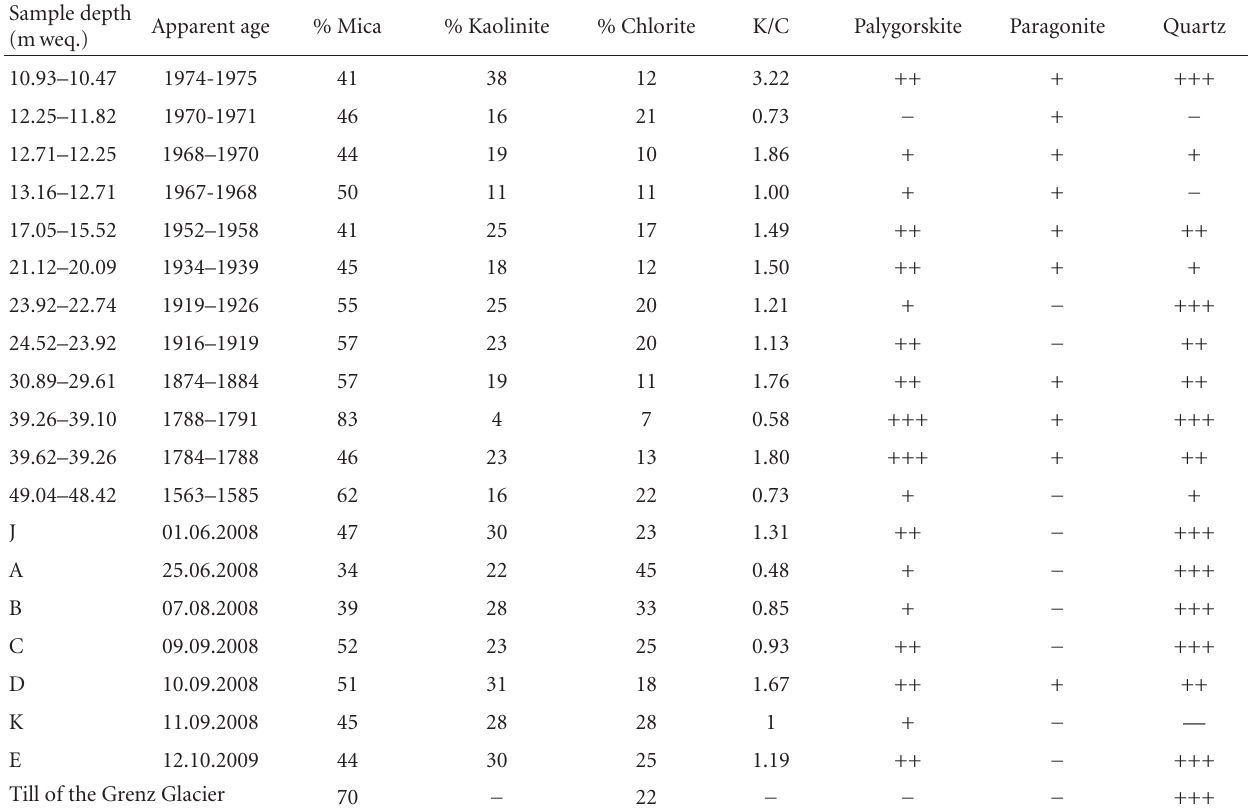
Table 2: Sample depth (meter water equivalent, mweq.) for the Colle Gnifetti (CG) ice-core samples (upper part), sample name for the Jungfraujoch (JFJ) samples (middle part), and X-ray mineral composition with K/C for kaolinite/chlorite ratio. The symbol plus (minus) shows the abundance (absence) of minerals. The composition of fine-grained sediment (till or glaciogenic clay and silt) collected on the Grenz Glacier is reported (lower part) for